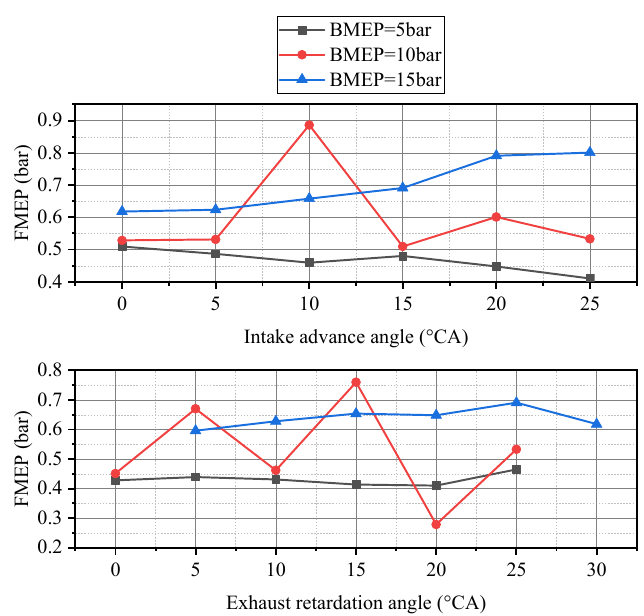
Figure 11. FMEP (Friction Mean Effective Pressure) versus intake advance angle under baseline EVC, and FMEP versus exhaust retardation angle under the Miller cycle at different points of operation during the test.